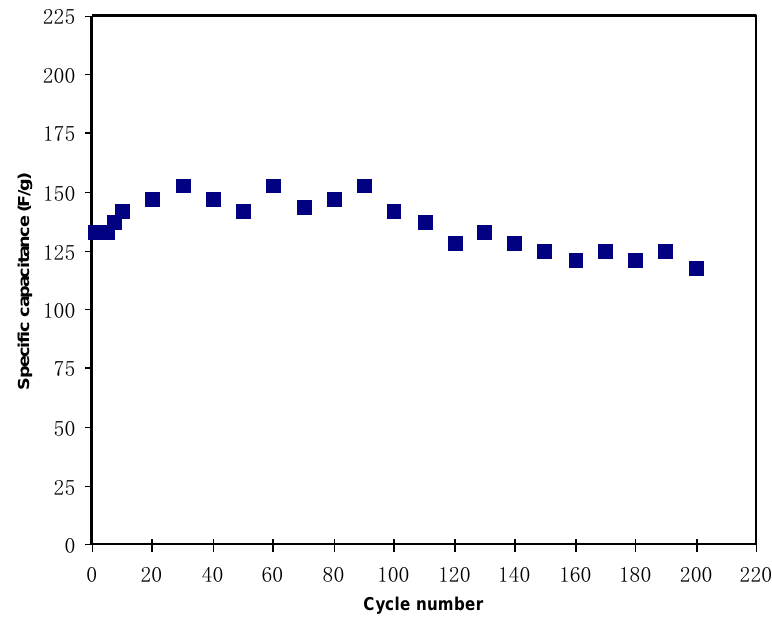
Figure 7. Specific capacitance of the EDLC for 200 cycles. Table 5. The specific capacitance values of EDLCs using various SPEs.